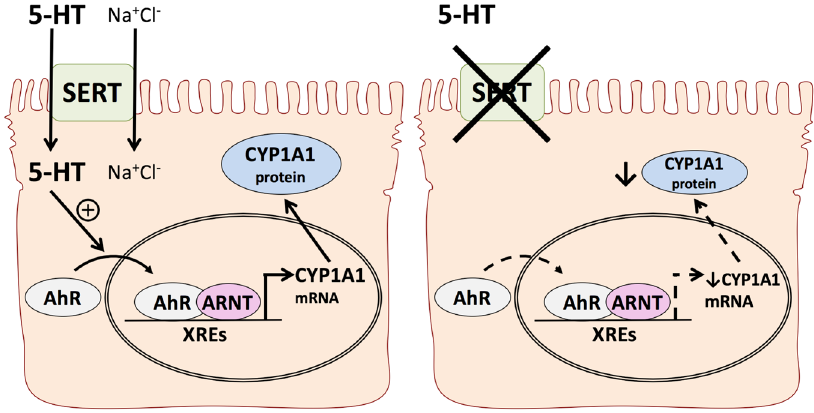
Figure 8. Proposed model of interactions between the serotonergic and AhR signaling pathways. In the intestinal mucosa of WT mice (left), enterocytes express SERT which is able to transport 5-HT into the cell via a Na + Cl − dependent process. Once inside the cell, 5-HT is able to activate AhR to induce nuclear translocation, dimerization with ARNT, and binding to XREs on AhR target genes. This will induce transcription of target genes such as Cyp1a1 which will be translated to protein. When SERT is absent as in SERT KO mice (right), enterocytes are not able to efficiently transport 5-HT into the cell. This will result in reduced AhR activation, and subsequently reduced expression of AhR target genes including Cyp1a1